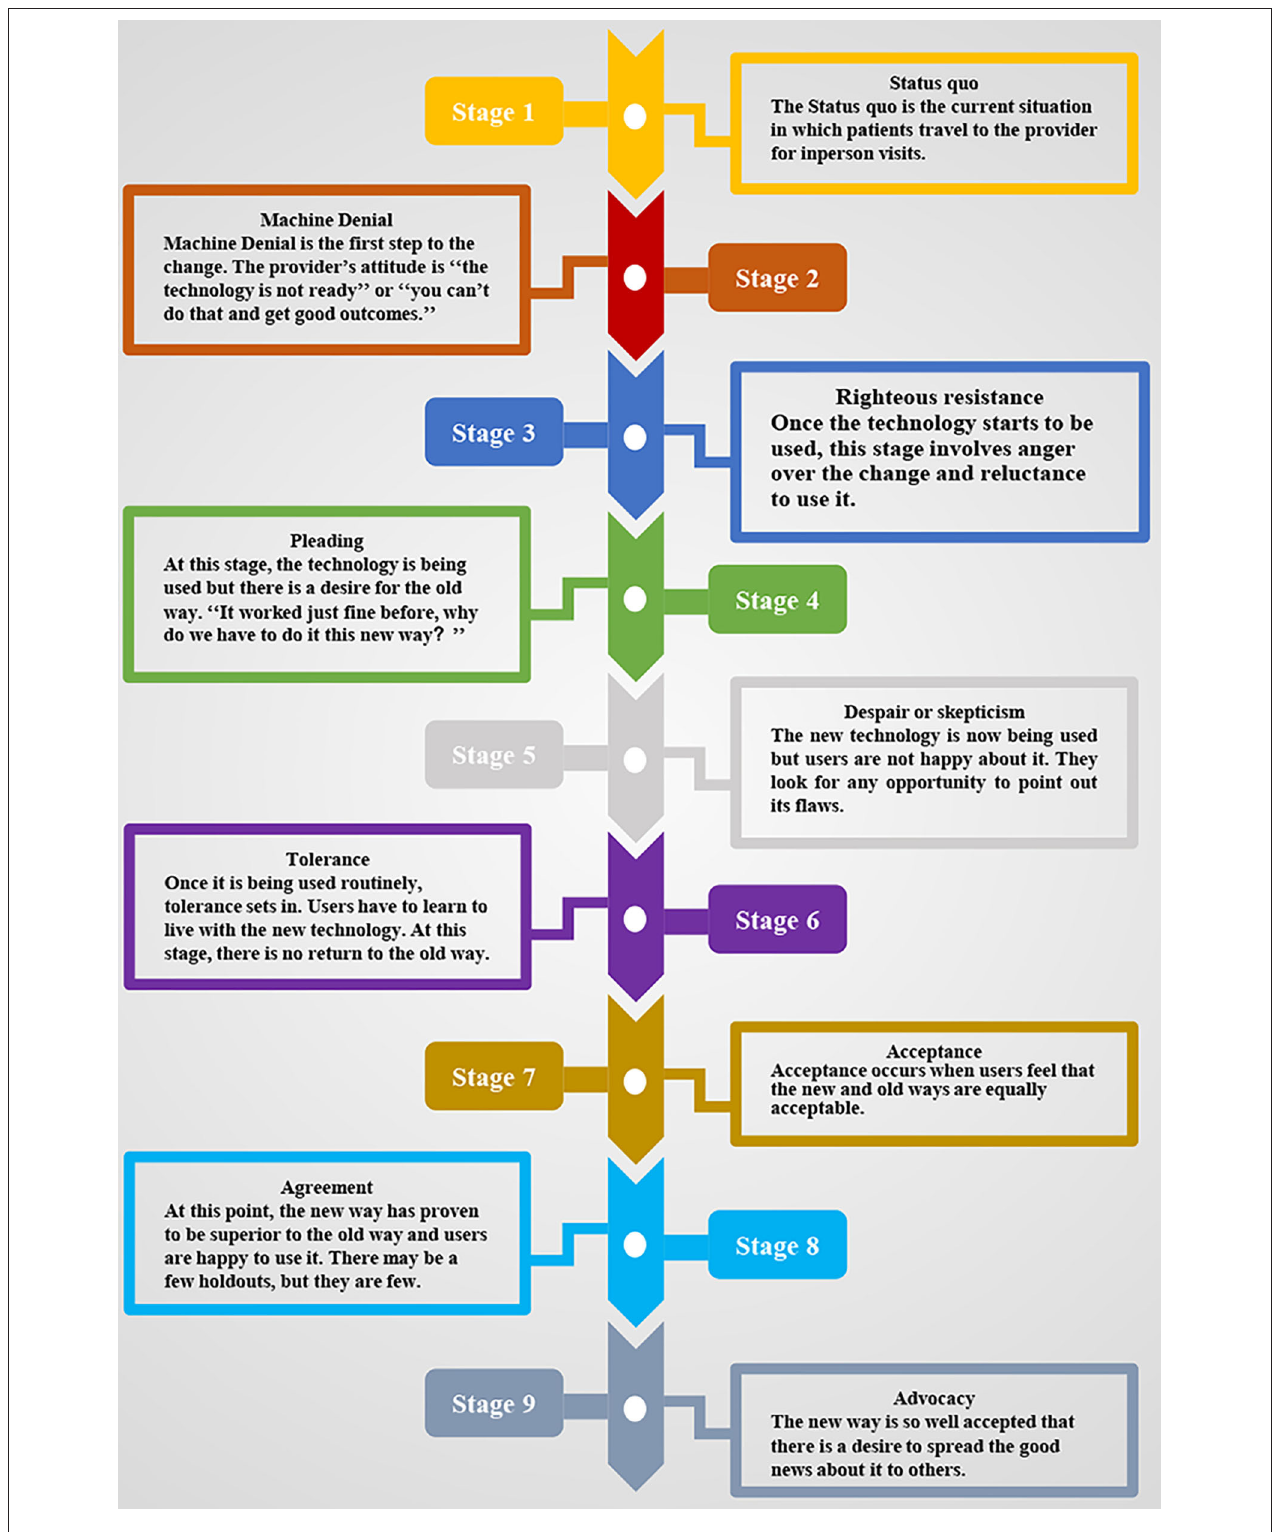
FIGURE 2 | The nine stages of transformational change of telemedicine (19).